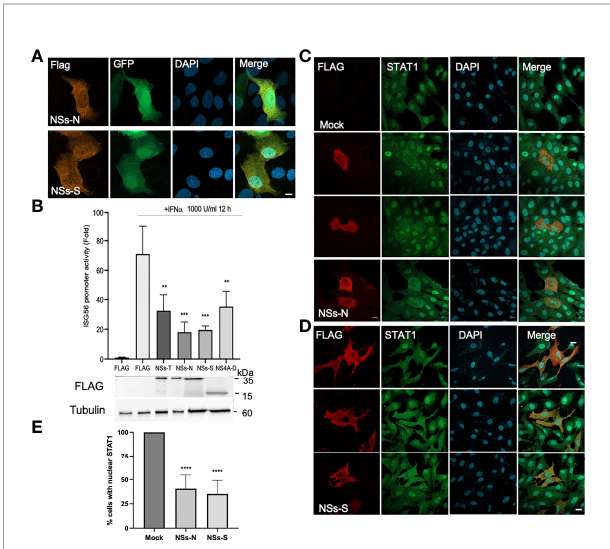
FIGURE 3 | NSs inhibits IFN mediated transcription and affects STAT1 localization. (A) Intracellular localization of NSs-N and NSs-S proteins. FLAG- tagged NSs proteins were cotransfected into U2OS cells with pEGFP-N1. The cells were fi xed and stained with anti-FLAG antibodies. (B) NSs mediated inhibition of IFN mediated transcription. ISG56 luciferase reporter cells were transfected with plasmids expressing sand fl y NSs, Dengue NS4A, or an empty plasmid. A Renilla luciferase-expressing plasmid was used as a transfection control. After 24 h, the cells were treated with IFN a (1000 U\ml). The cells were harvested after an additional 12 h, and luciferase activity was determined. Shown is a representative experiment from three independent experiments showing similar results (**P<0.01, ***P<0.001, One way ANOVA, Dunnett ’ s multiple comparisons test). The lysates from the luciferase assay were subjected to western blot analysis using FLAG antibodies. Tubulin was used as a loading control. (C, D) NSs affects STAT1 localization. Vero cells were transfected with FLAG-tagged NSs expressing plasmids. The cells were stimulated with IFN a (1000 U/ml) for 30 min 24 h post-transfection, then fi xed and stained with anti-FLAG (red) and anti-STAT1 (green) speci fi c antibodies. DAPI was used for nuclei labeling (blue). (E) The percentage of transfected cells with nuclear STAT1. Results are representative of three independent experiments (n=50 cells for each condition ****P<0.0001, One way ANOVA, Dunnett ’ s multiple comparisons test). Scale bar = 10